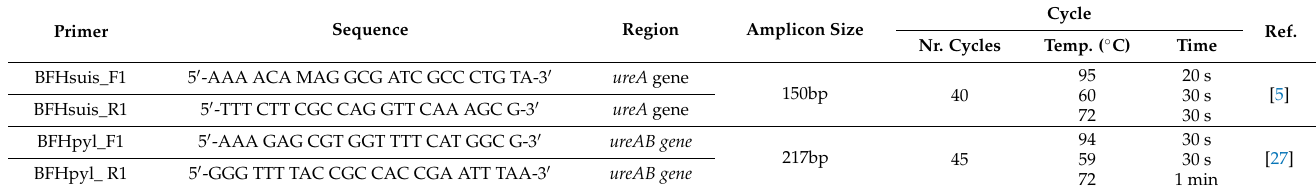
Aliquots of each PCR product were electrophoresed on 1.5% agarose gel, stained